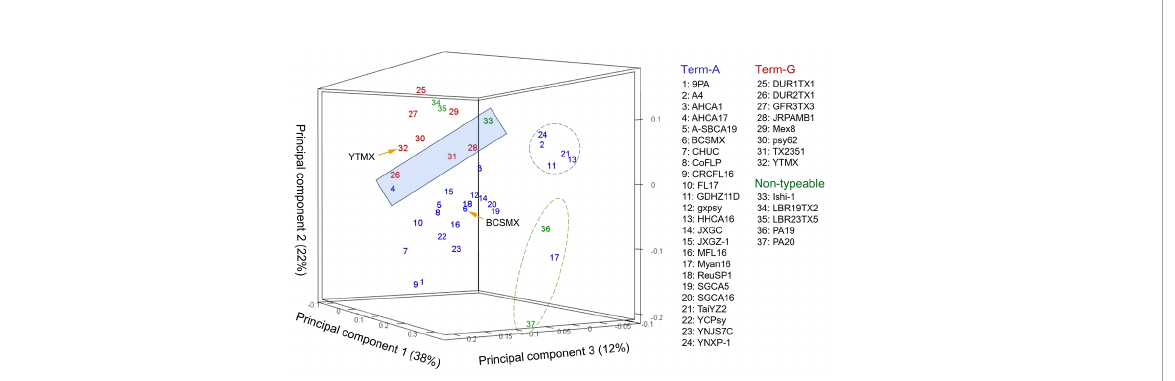
FIGURE 2 Relationships of “ Candidatus Liberibacter asiaticus ” (CLas) strains revealed by an unsupervised marchine learning (ML) tool (principal component analysis) on average nucleotide identity (ANI) values. Each strain is represented by a number with the correspondent names listed on the right. Blue numbers represent Term-A group; Red numbers represents Term-G group; and green numbers represents non-typable for Term-A or Term-G. Note that strains in the shaded box borderline between Term-A and Term-G groups. The grouping status of the borderline strains as well as the non-typeable strains was resolved/con fi rmed in a supervised ML approach (Figure 3). Although not the objective of this study, it was interesting to note that strains in blue circle harbored Type 2 prophage only, and strains in green circle were of South Asia origins (#17 from Myanmar; #36 and #37 from Pakistan).